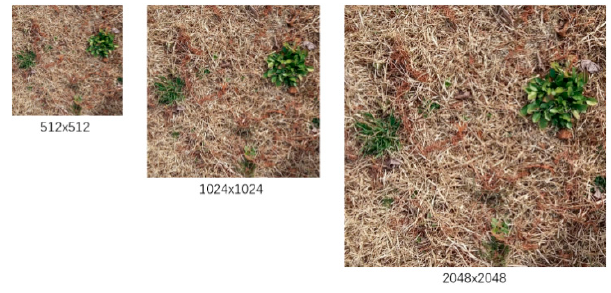
Figure 8. Example results of multi-scale image.